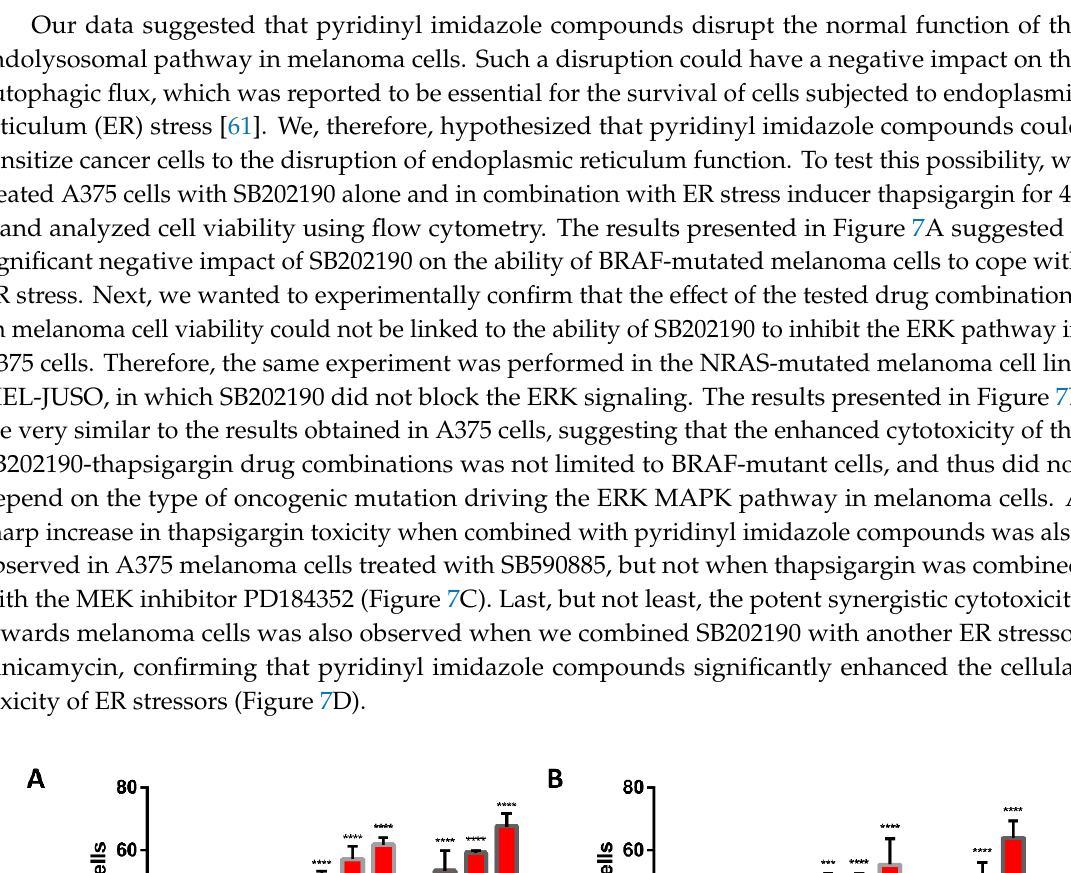
Figure 7. Pyridinyl imidazole compounds sensitize human melanoma cells to endoplasmic reticulum (ER) stress. Propidium iodide-based flow cytometry analysis of cell viability treated with small molecule compounds for 48 h. Presented data were obtained in three independent experiments. ( A ) Viability of BRAF-mutated A375 cells treated with SB202190 (SB; 5, 10, and 15 μM) in combination with ER stressor thapsigargin (T; 50 and 100 nM). ( B ) Viability of NRAS-mutated MEL-JUSO melanoma cells treated with SB202190 (SB; 5, 10, and 15 μM) in combination with thapsigargin (T; 50 and 100 nM). ( C ) Viability of A375 cells treated with thapsigargin (T; 50 nM) together with pyridinyl imidazole inhibitors SB202190 (SB202; 15 μM) and SB590885 (SB590; 5 μM), and MEK inhibitor PD184352 (PD; 0.5 μM). ( D ) Viability of A375 cells treated with SB202190 (SB202; 15 μM) in combination with ER stress inducers thapsigargin (T; 50 nM) and tunicamycin (Tu; 0.5 μM). ** denotes p < 0.01, **** indicates p < 0.0001 3. Discussion The BRAF oncogenic signaling is a prime therapeutic target in melanoma, and small molecule BRAF inhibitors dabrafenib and vemurafenib have been approved for clinical use. While they are extending the survival of melanoma patients, there is still room for improvement. BRAF-targeted therapy is commonly associated with acquired drug resistance and undesired off-target effects, such as the paradoxical activation of RAF signaling in healthy tissue [6,62]. Another approach to prevent acquired drug resistance could be a simultaneous targeting of two essential signaling pathways in melanoma cells. Reports are suggesting that overactivation of the PI3K/AKT/mTOR pathway might contribute to the survival of melanoma cells upon BRAF V600E inhibition and that dual targeting of advanced human cancers with inhibitors of the PI3K/AKT/mTOR and RAF/MEK/ERK pathways might be beneficial [7,63]. A close link between these two signaling pathways in BRAF mutated melanoma cells was also shown in a study that analyzed intrinsic cross-resistance to inhibitors of the two pathways [64].